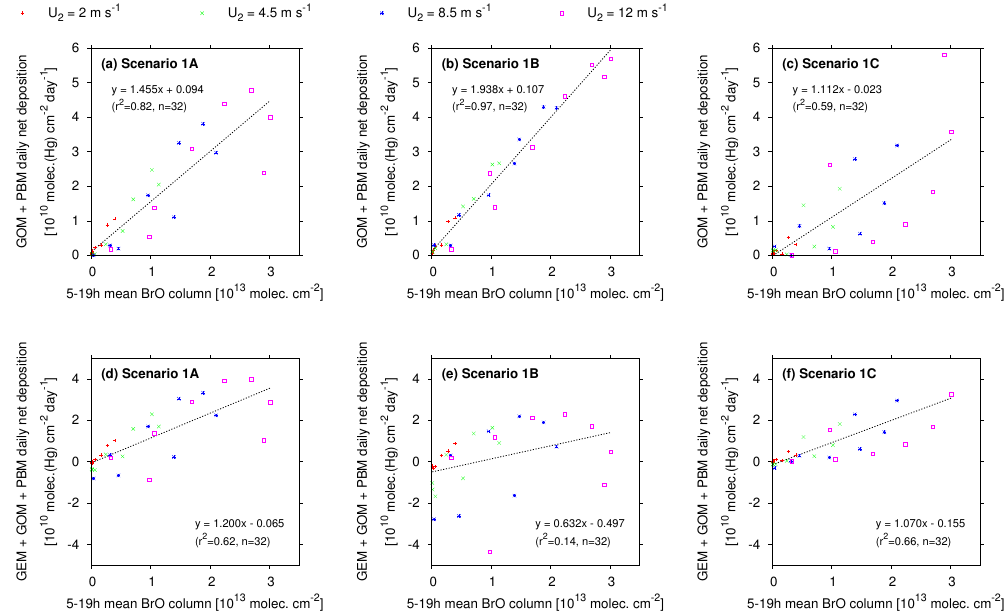
Fig. 12. Correlations between the daytime column amount of BrO in the atmosphere and the daily net deposition of mercury, either excluding GEM (a–c) or including GEM (d–f) , from the atmosphere to the snowpack on each simulated day (Day 1 to 8), plotted collectively from model runs at U 2 = 2 . 0 ms − 1 , 4.5ms − 1 , 8.5ms − 1 , and 12.0ms − 1 for each of the scenarios 1A–C: (a) and (d) scenario 1A, (b) and (e) scenario 1B, and (c) and (f) scenario 1C.